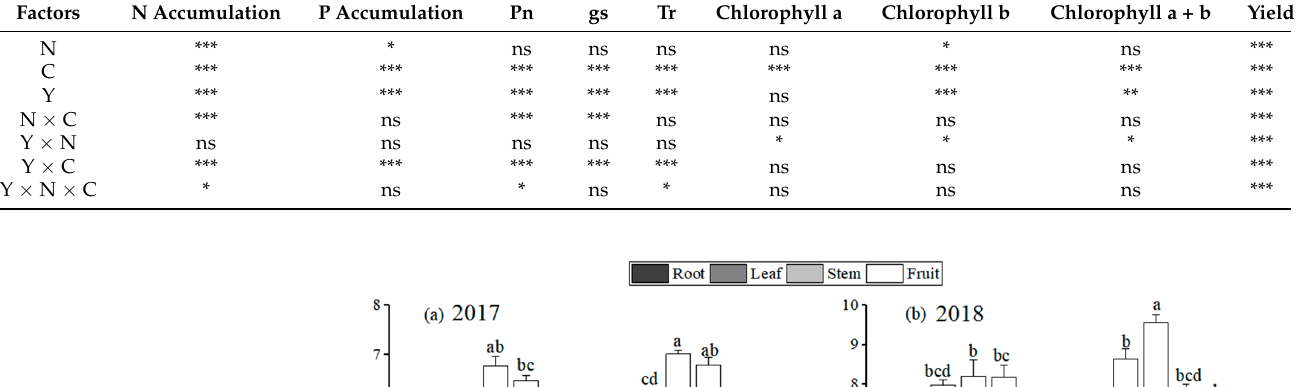
Table 1. Output of two-way ANOVA of N accumulation, P accumulation, Pn, gs, Tr, chlorophyll a, chlorophyll b, chlorophyll a + b and yield as affected by N (N1 and N2), biochar (C0, C10, C30, C50, C70 and C90) and year (2017 and 2018). *, ** and *** indicate significance levels at p < 0.05, p < 0.01 and p < 0.001, respectively, and ns denotes no significance.